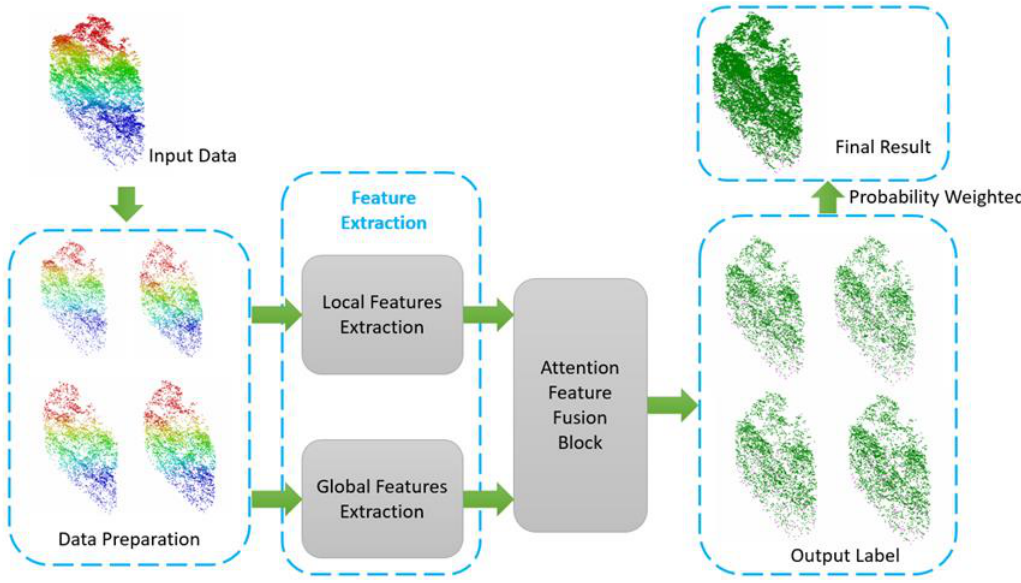
Figure 1. Overview of our proposed framework for the digital elevation model (DEM) extraction of airborne laser scanning (ALS) point clouds (colors represent various categories).